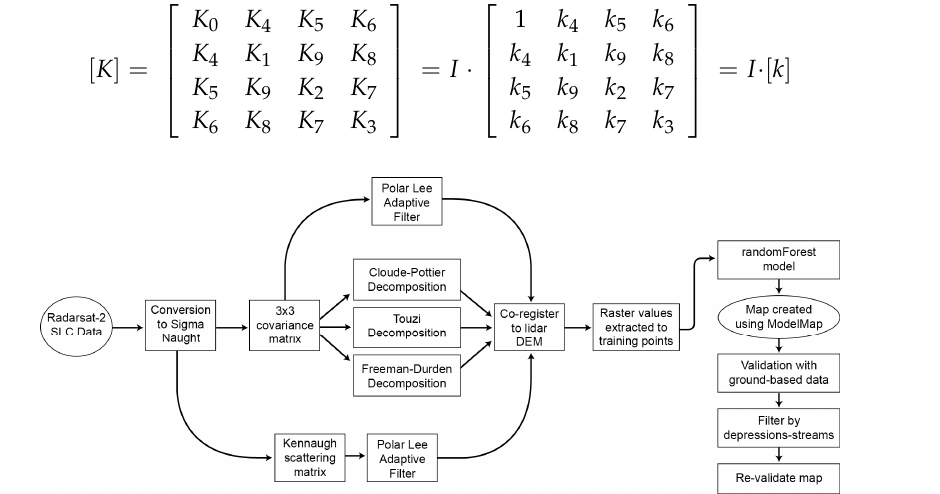
Figure 3. Flowchart of Radarsat-2 processing steps. SLC: Single Look Complex. DEM: digital Figure 3. FlowchartofRadarsat-2processingsteps. SLC:SingleLookComplex. elevation model.